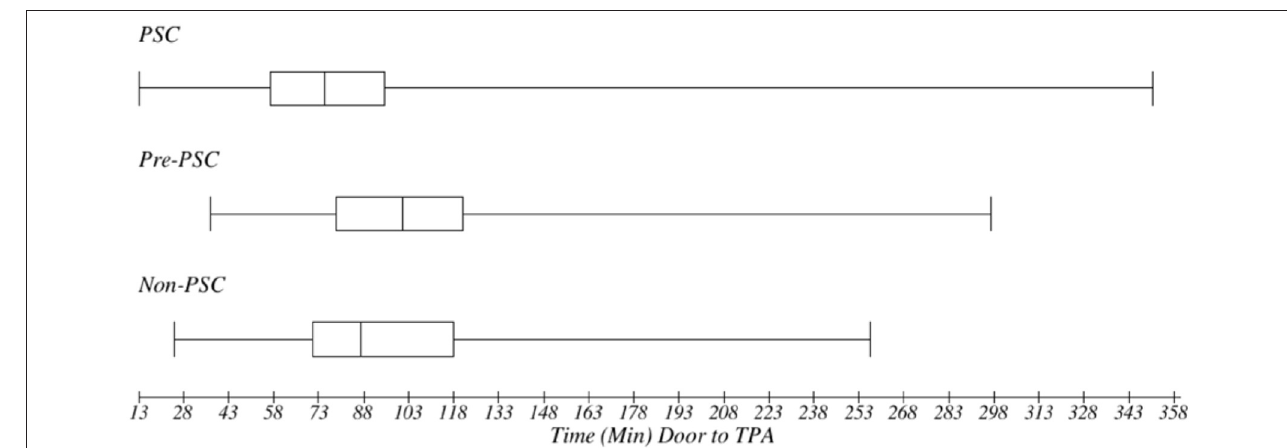
FIGURE 3 | Metrics of acute stroke care quality: median time with interquartile range (minutes) from door to tPA initiation: in treated cerebral ischemia cases, time in minutes from ED arrival (door) to initiation of tPA was 75 (57–95) at PSC, 101 (79–121) at pre-PSC, and 87 (71–118) at non-PSCs ( p < 0.001). PSCs had a reduced time from door to